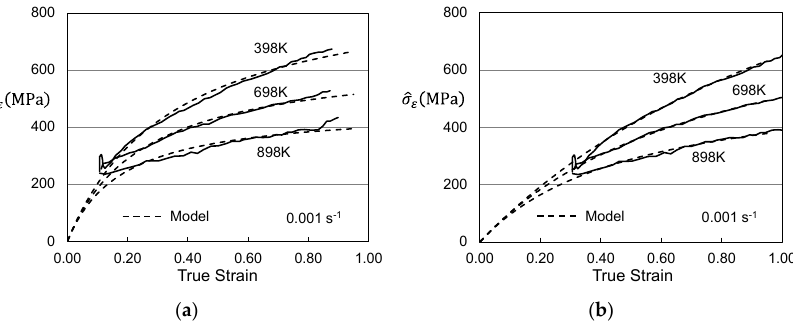
Figure 13. Assessed evolution for Cheng et al. molybdenum. ( a ) Variation with strain assuming an initial strain of 10%; ( b ) Variation with strain assuming an initial strain of 30%. Table 5 lists the evolution law model parameters for all three assumed initial strains. Table 5. Evolution model parameters for the three assumed initial strains. Model Parameter